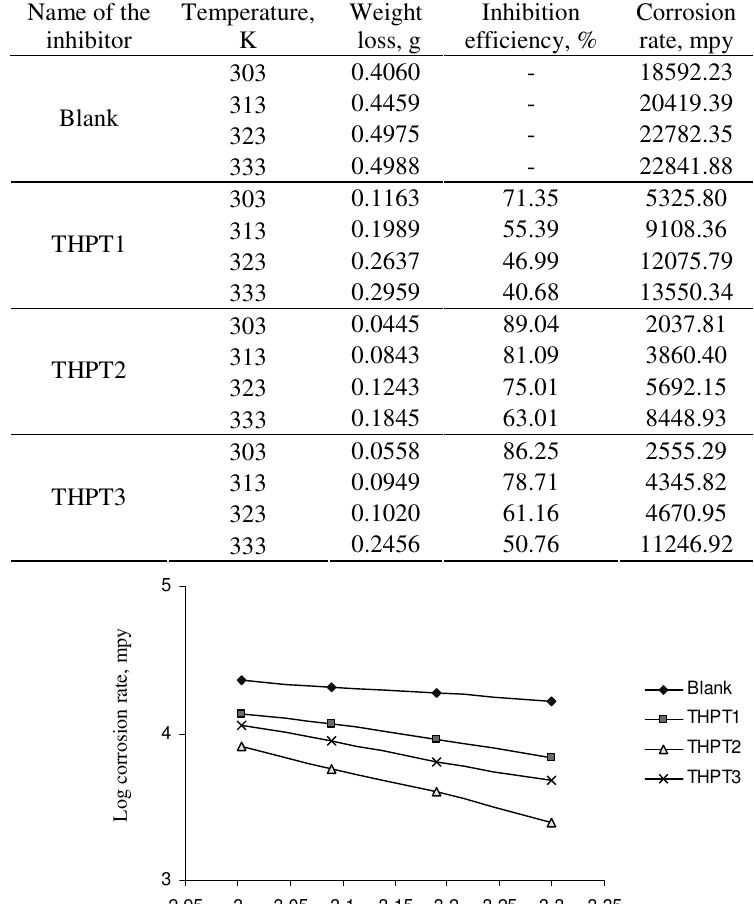
Table 3. Inhibition efficiencies of 10 m M concentration of various inhibitors for corrosion of mild steel in 1 M H SO obtained by weight loss measurement at higher temperatures. 2 4